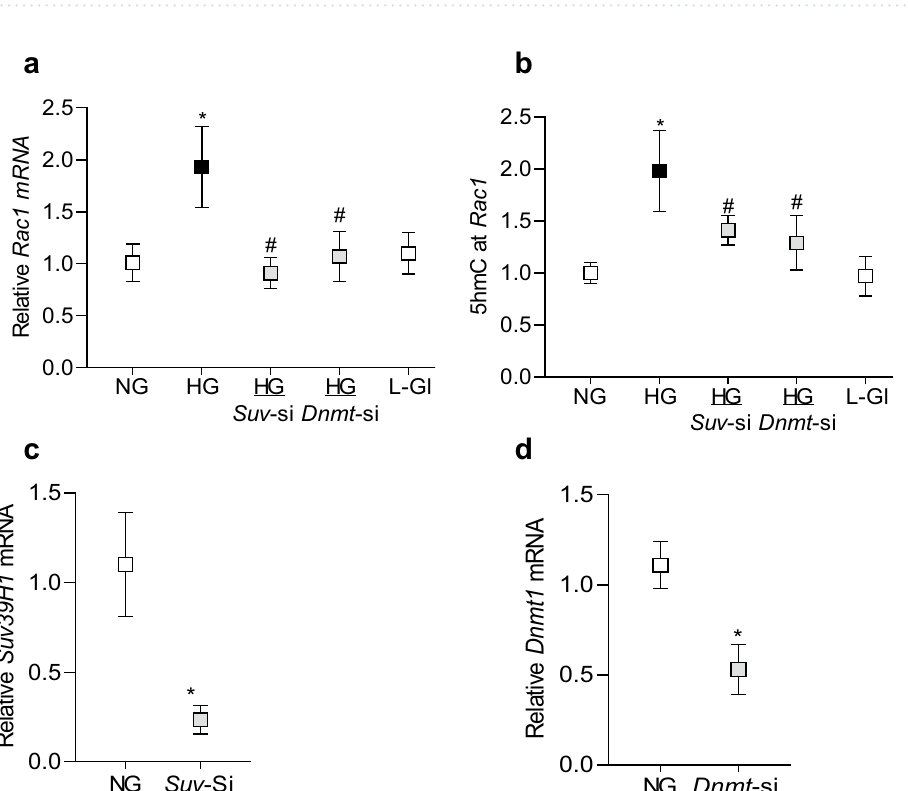
Figure 3. Regulation of Rac1 gene transcripts and 5hmC at its promoter. Cells transfected with Suv39H1 - siRNA ( Suv -si) or Dnmt1 -siRNA ( Dnmt -si), incubated in high glucose for four days, were analyzed for Rac1 ( a ) gene transcripts by qRT-PCR using β-actin as a housekeeping gene and ( b ) 5hmC at its promoter by immunoprecipitating 5hmC in the genomic DNA , and quantifying by qRT-PCR using gene specific primers. Transfection efficiency of ( c ) SuvH39H1 -siRNAs and ( d ) Dnmt1 -siRNA was determined by quantifying its gene transcripts. NG and HG = cells in 5 mM or 20 mM D-glucose respectively, HG/ Suv -si and HG/ Dnmt1 -si = cells transfected with Suv39H1 -siRNA or Dnmt1 -siRNA, and incubated in 20 mM D-glucose, Suv -si and Dnmt -si = cells transfected with Suv39H1 -siRNA or Dnmt1 -siRNA. * p < 0.05 vs NG and # p < 0.05 vs